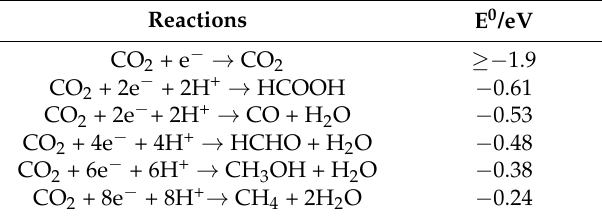
Table 2. Reduction potentials for the CO 2 reduction process. E 0 : Standard reduction